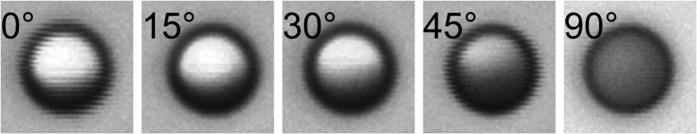
Microscopy images of a magnetic Janus particle with a diameter of 4.54 μm for different orientations θ.The ratio between the projected area of the transparent (bright) hemisphere and the coated (black) hemisphere serves as measure for the radial orientation θ of the particle.